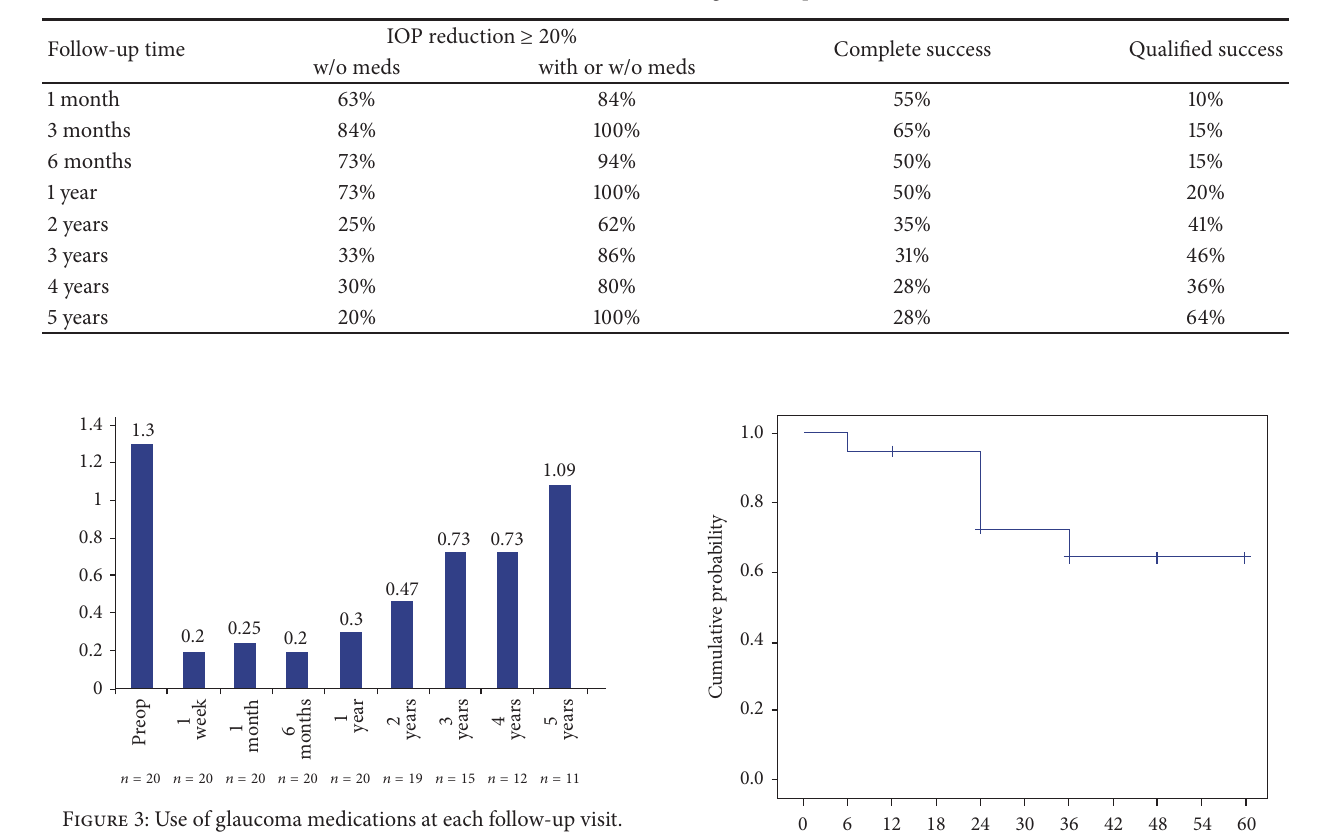
Table 3: Success rates recorded during follow-up (w/o: without).